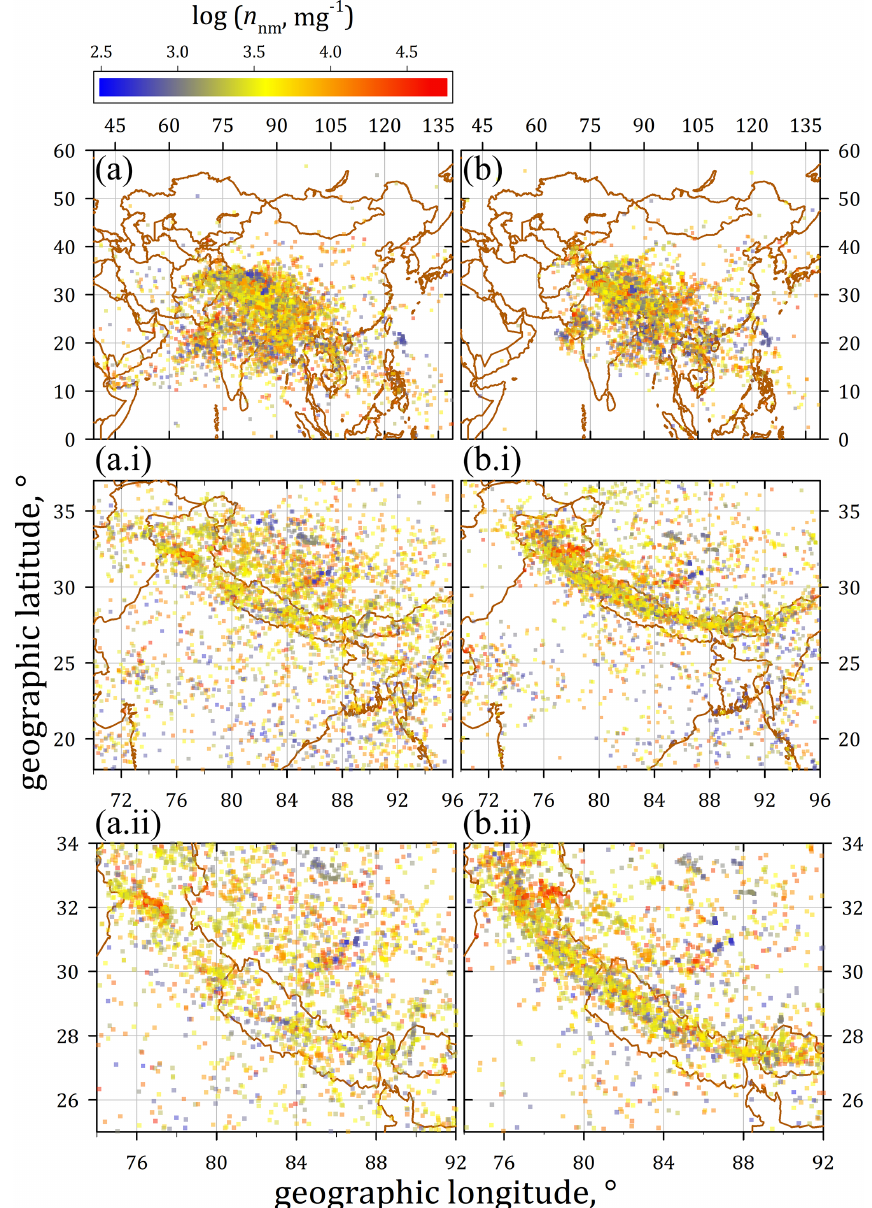
Figure 9. From backward trajectory analyses by means of the chemistry transport model ClaMS and based on ERA5 data. (a) The geographic position of the last boundary layer (BL) contact of the NPF-connected air mass backward trajectories. (b) The geographic position of the maximum ascent rate. Subpanels a.i and a.ii (b.i and b.ii) provide two-level zoom-ins of the respective main panel (a) or (b) based on the same data set. The backward trajectories were analysed over the last 50d prior to the NPF detection as a starting point of each trajectory. Here, the data points are coloured with reference to the (logarithmic) mixing ratio n nm of nucleation-mode particles; grey data points indicate transport times >